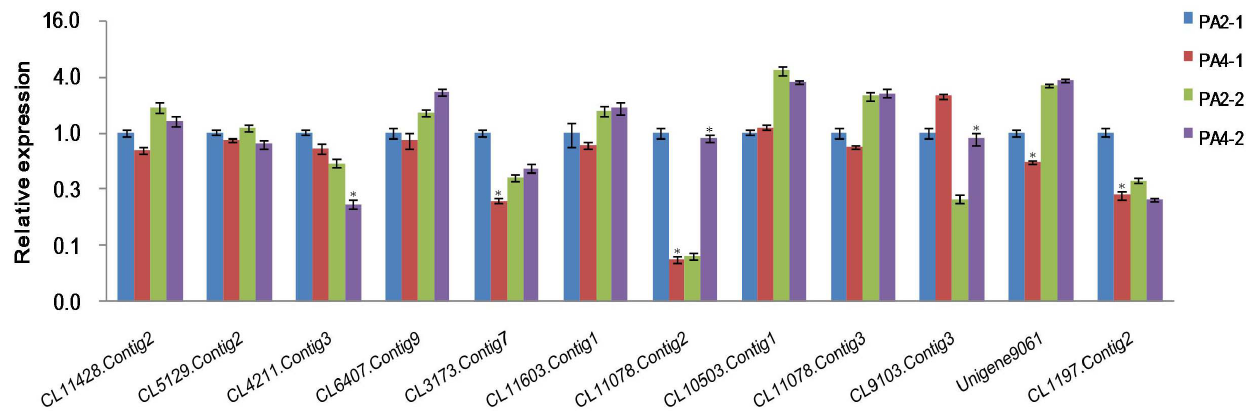
Figure 3. Relative expression levels of the target genes in P.australis . PA2-1, 30-day-old diploid in vitro plantlets; PA4-1, 30-day-old autotetraploid in vitro plantlets; PA2-2, two-year-old diploid saplings; PA4-2, two-year-old autotetraploid saplings. CL11428.Contig2 (SPL6) and CL5129.Contig2 (SPL12) targeted by pas-miR156c, CL3173.Contig7 (ARF10) and CL11603.Contig1 (ARF18) targeted by pas-miR160a, CL4211.Contig3 (ARF8) and CL6407.Contig9 (ARF6) targeted by pas-miR167, CL11078.Contig2 (SCL6), CL10503.Contig1 (SCL15) and CL11078.Contig3 (SCL22) targeted by pas-miR171a, CL9103.Contig3 (Transcription factor TCP4) targeted by pas-miR319a-3p; Unigene9061 (Serine/threonine protein kinase) targeted by pas-mir1; CL1197.Contig2 (Zinc finger CCCH domain-containing protein 53) targeted by pas-mir22-3p. Three independent biological replicates were performed. Values are means 6 SD (n=3).The expression levels of targets were normalized to 18SrRNA. The normalized miRNA levels in the PA2-1 were arbitrarily set to 1. *: Statistically significant differences between PA2 and PA4 under the same developmental stages (p-value was less than 0.05)